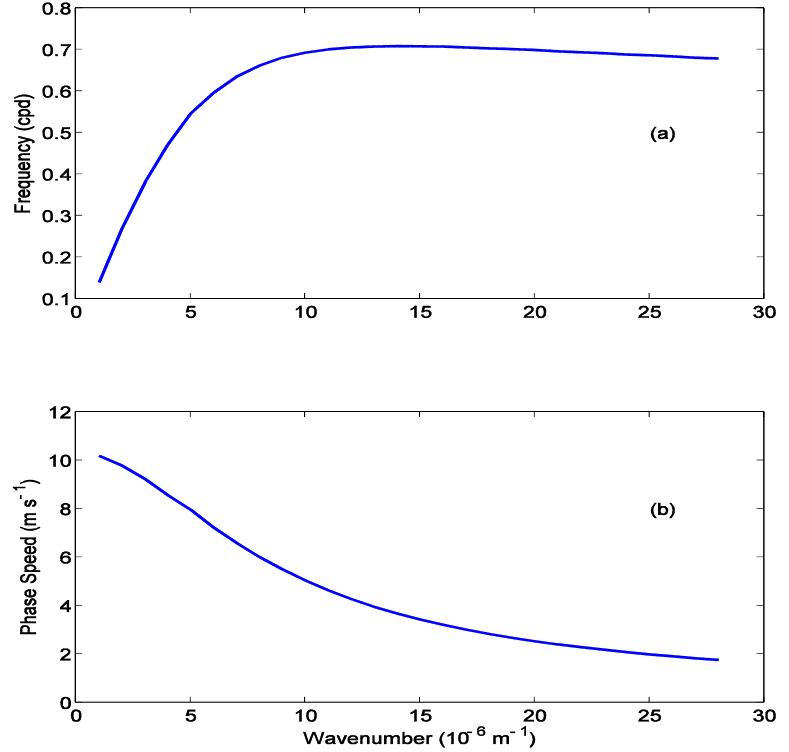
Figure 12. ( a ) The dispersion relationship estimated for the first-mode continental shelf wave in the coastal area nearby the T/P ground track; ( b ) the corresponding wave speed curve.